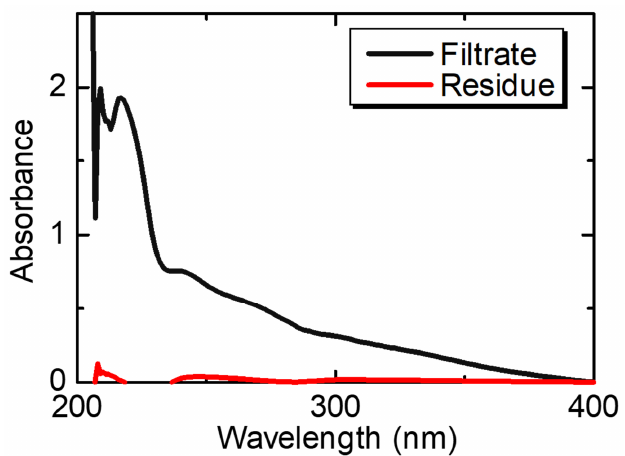
Figure 5. Absorbance of the HGHGH nanoparticle filtrate and residue after protease treatment for six days. The volume rate of the residue/filtrate was 0.2/2.8 mL/mL, and the calculated degrees of residue and filtrate concentration were 15 and 1.1, respectively. The absorbance values of the residue and filtrate at 273 nm were 0.49 and 0.01, respectively, and were assigned to the HGHGH aromatic group. These results indicated that protease degrades the pep- tide bonds of these HGHGH nanoparticles by 98% within six days. The radiation-cross- linked HGHGH nanoparticles were biodegraded effectively because their side chains are crosslinked and the original chemical structure of their main chain is preserved. Because the His dimer produced after biodegradation is smaller than the glomerular meshwork (7 nm) of the kidney [15,20], it easily passes through this network and can be rapidly excreted from the blood. We therefore concluded that HGHGH nanoparticles do not accumulate in the blood. Indeed, they are biodegraded by the enzymes within a week, after which they are rapidly excreted from the body. The biodegradability of HGHGH is similar to that of the radiation-induced nanoparticles from gelatin, which displayed 95% degrada- tion in seven days by protease [35]. The stability and biodegradability of HGHGH nano- particles are not expected to be affected by staining.